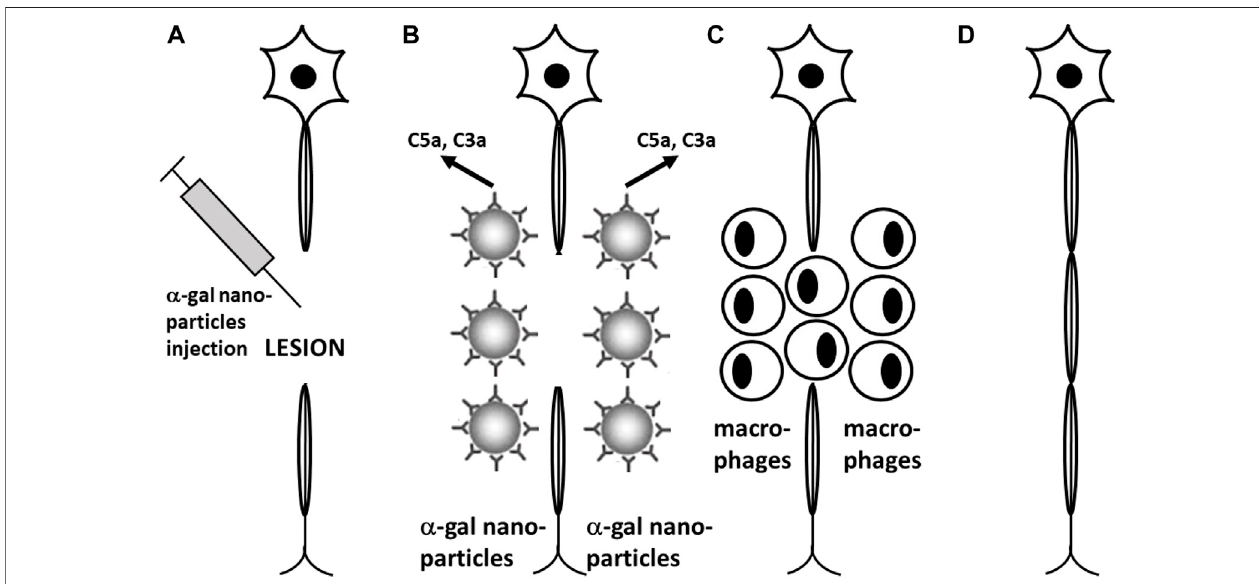
FIGURE11| Proposed experimental α -galtherapy forinducingregeneration ofinjurednerves and spinal cord byadministration of α -gal nanoparticles tothelesion area. (A) α -Gal nanoparticles are injected into the spinal cord or peripheral nerve lesions following injury. (B) Anti-Gal (illustrated as IgG molecules) binding to α -gal nanoparticles activates the complement system to generate complement cleavage chemotactic peptides C5a and C3a. (C) Chemotactic complement peptides recruit macrophages to the lesion. Macrophages that bind immunocomplexed α -gal nanoparticles via Fc/Fc γ receptors are activated into pro-reparative macrophages that secrete various cytokines/growth factors including vascular endothelial growth factor (VEGF). (D) VEGF secreted by the recruited macrophages induces local neo- vascularization. Axonal sprouts growing along newly formed capillaries cross the lesion area and reconnect with endoneurial tubes in the distant axonal segment, resultingingrowthoftheseveredaxons. (E) Newlygrownaxonsaremyelinated,therebycompletingregenerationoftheinjurednerve.ReprintedfromGaliliU. Thenatural anti-Gal antibody as foe turned friend in medicine. Publishers Academic Press/Elsevier, London, 2018, with